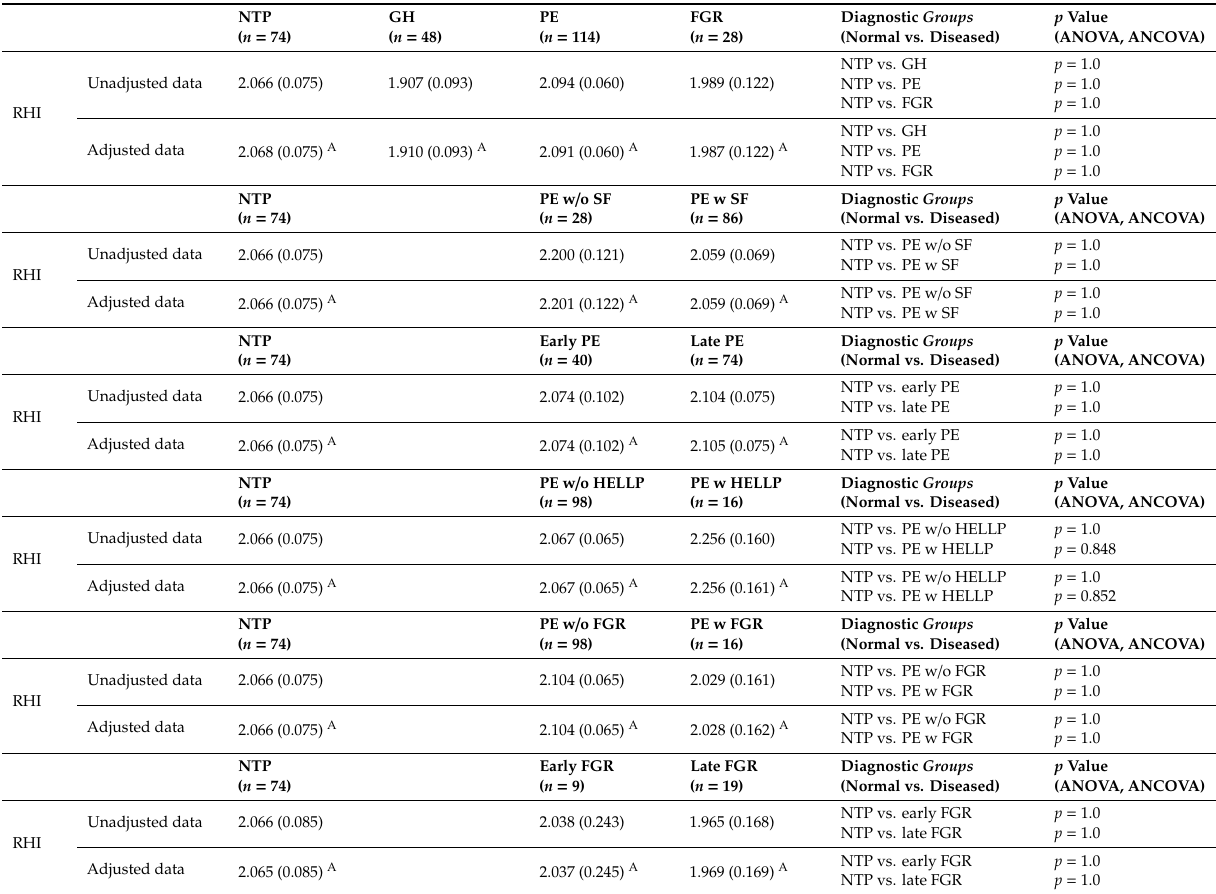
Table 4. Impact of a history of pregnancy-related complications (GH, PE, FGR) with respect to the severity of the disease and delivery date on vascular endothelial function (RHI values)_ overview (ANOVA and ANCOVA